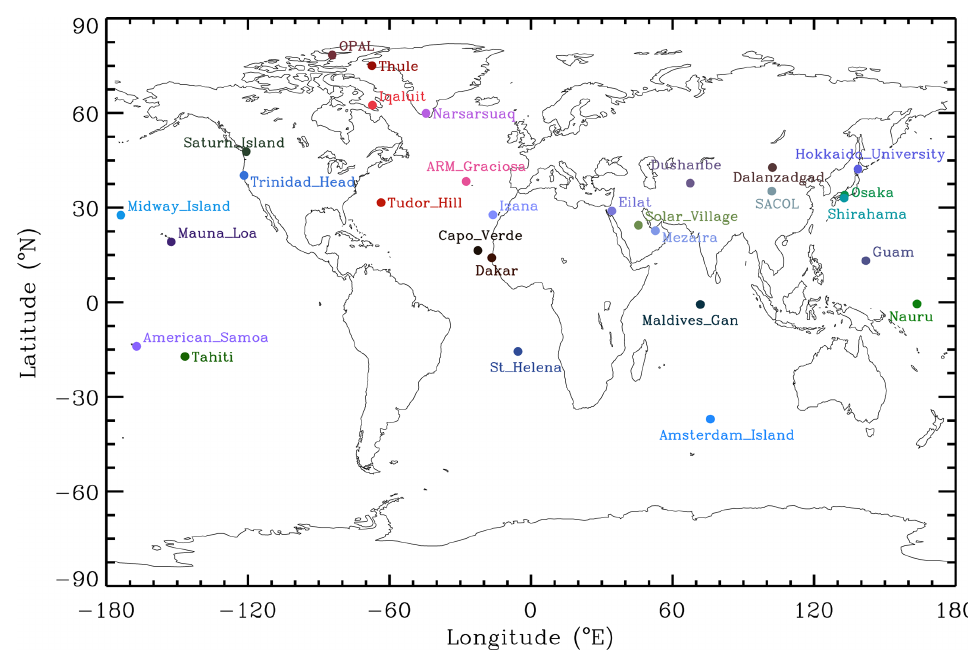
Figure 1. Overview of the oceanic and coastal (20 sites) and near-desert (9 sites selected from Ansmann et al., 2019b) AERONET sites used in this study. Labels for each site are taken from the AERONET site list.